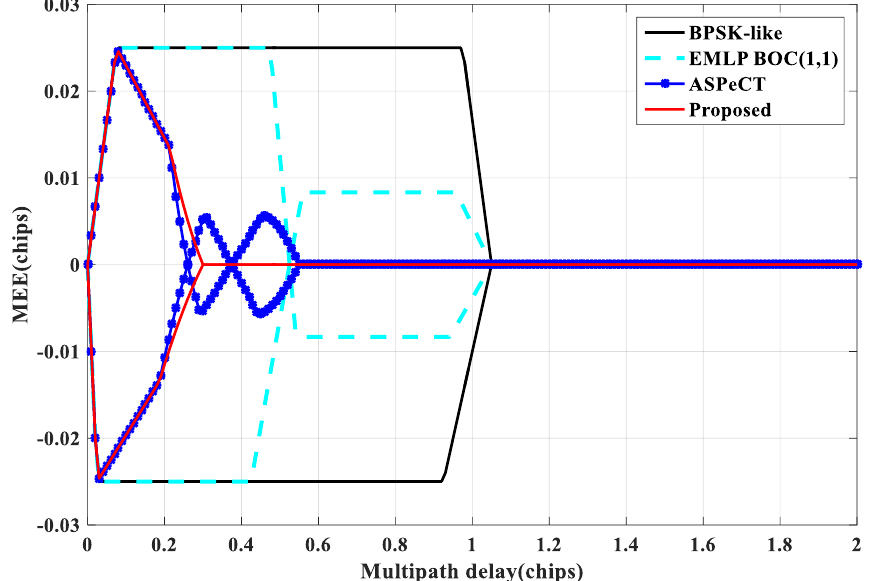
Figure 20. Discriminator output curve of BOC(10,5).